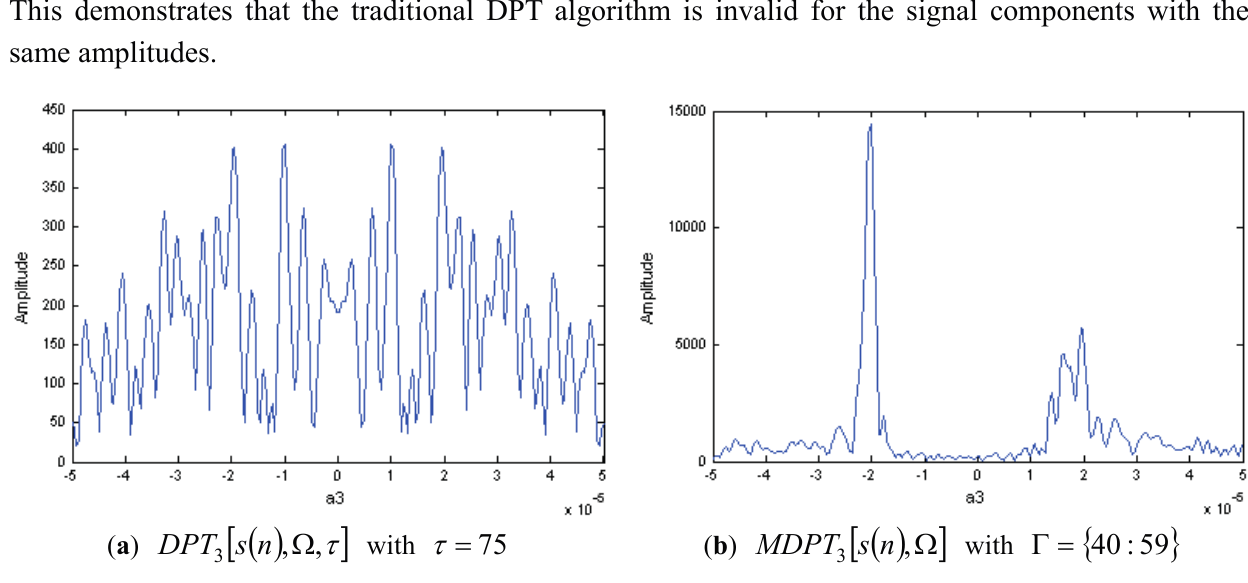
Figure 4. DPT and MDPT of a two-component CPS with same